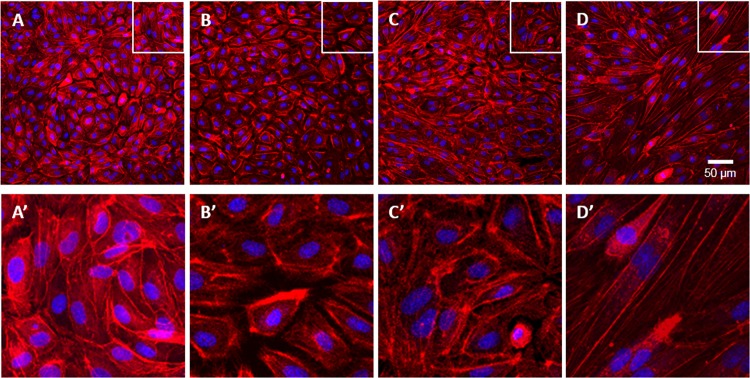
HUVEC actin cytoskeleton remodeling following treatment with increasing concentrations of β-escin.Upper panel: actin staining of: A—control cells; B, C, D—β-escin-treated cells (1, 2 and 3 μM, respectively). Lower panel (A’, B’, C’, D’): magnification of selected fragments. Similar results were observed in three independent experiments with cells obtained from three donors.